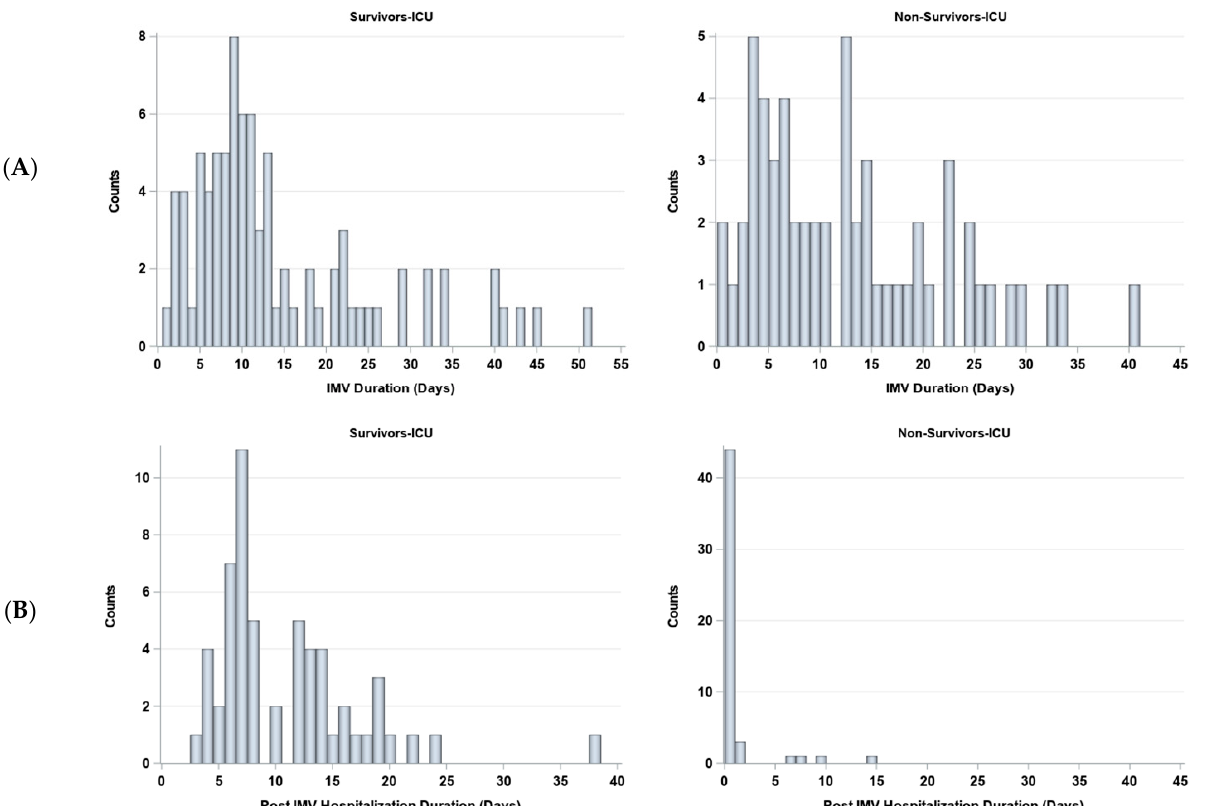
Figure 6. Histograms of days ( A ) on and ( B ) off invasive mechanical ventilation (IMV) for survivors ( N = 85) and non-survivors ( N = 58). Table 3. Correlation (R) of geographic and opacity CXR scores with clinical variables. * p < 0.05. Data from admission and outcome were analyzed together.